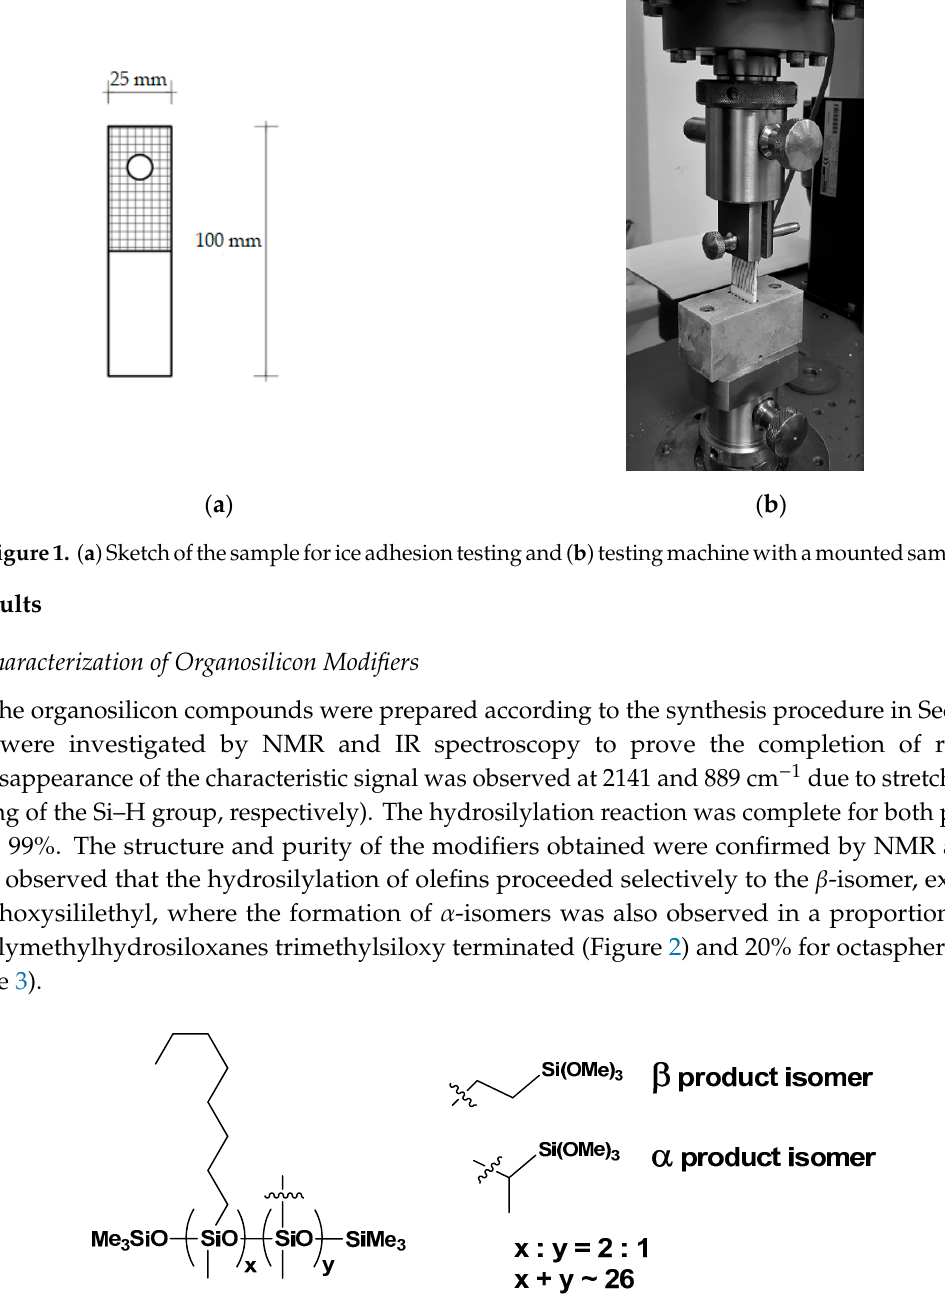
Figure 2. Structure of poly((methyloctylsiloxane)-co-(methyl(trimethoxyethyl)siloxane)), trimethylsilyl terminated.